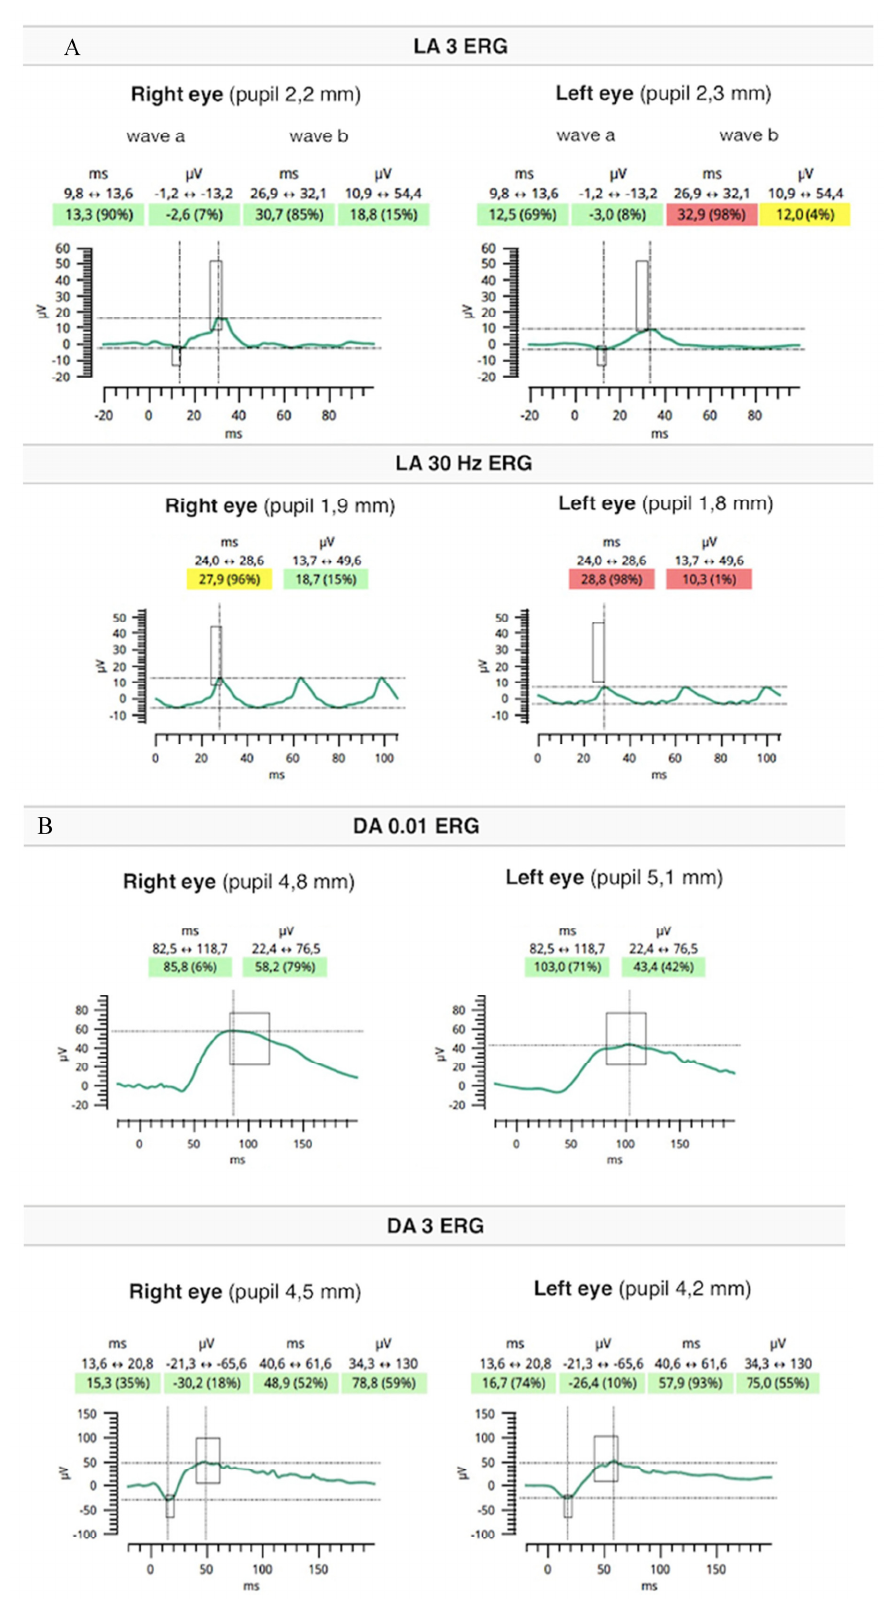
Figure 5. Flash ffERG showed lowering of a and b waves in light-adapted (LA) 3 ERG and LA 30 Hz ERG as well as prolonged peak times of a and b waves (significantly worse in the RE) ( A ). Dark-adapted (DA) 0.01 ERG and DA3 were within normal limits ( B ).